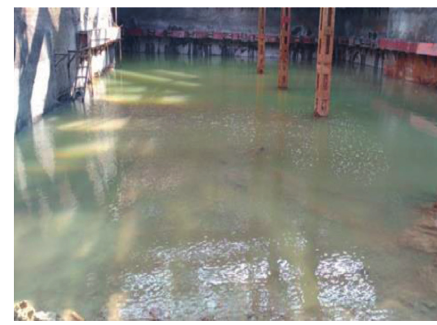
Figure 11: Water